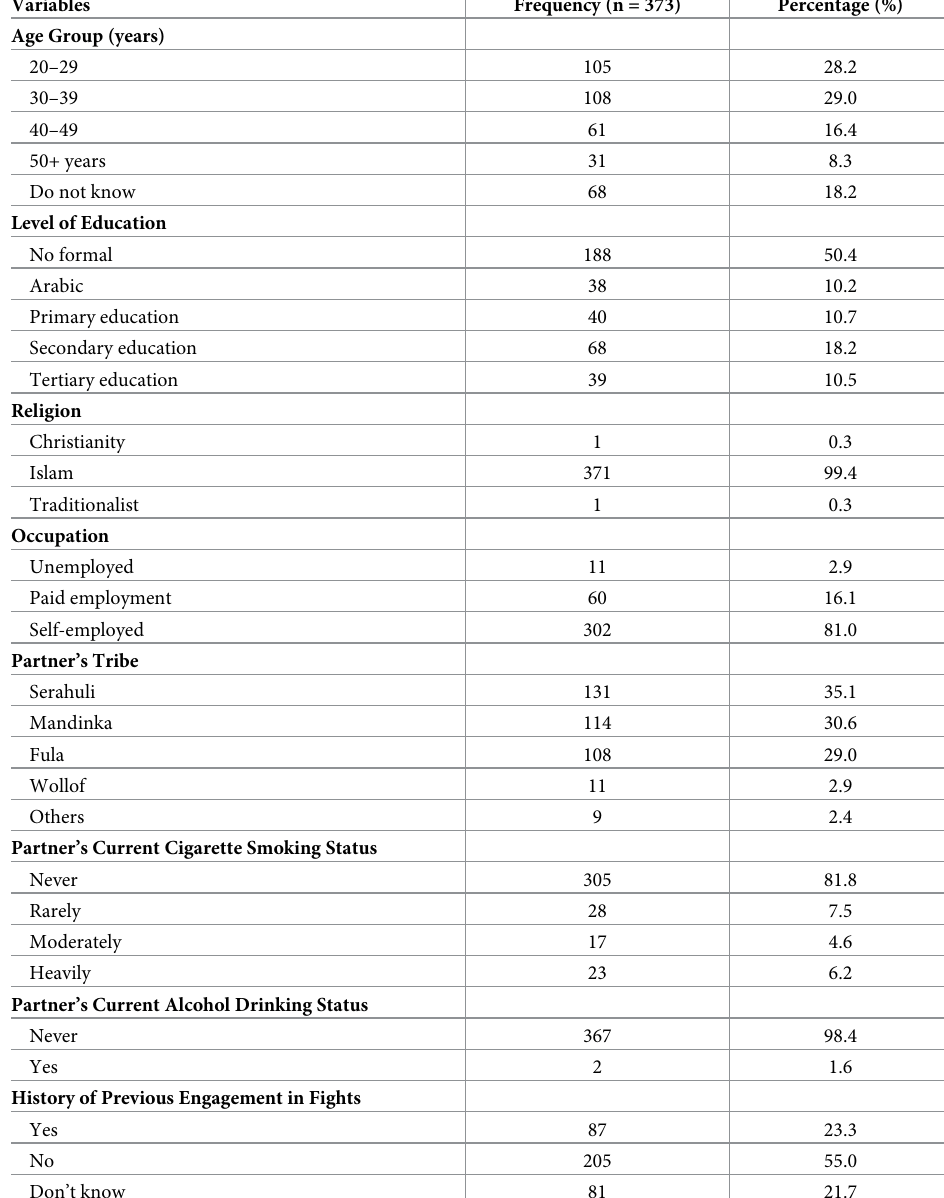
Table 3. Sociodemographic and lifestyle characteristics of partners of pregnant women seeking antenatal service at public health care facilities in the rural Gambia,